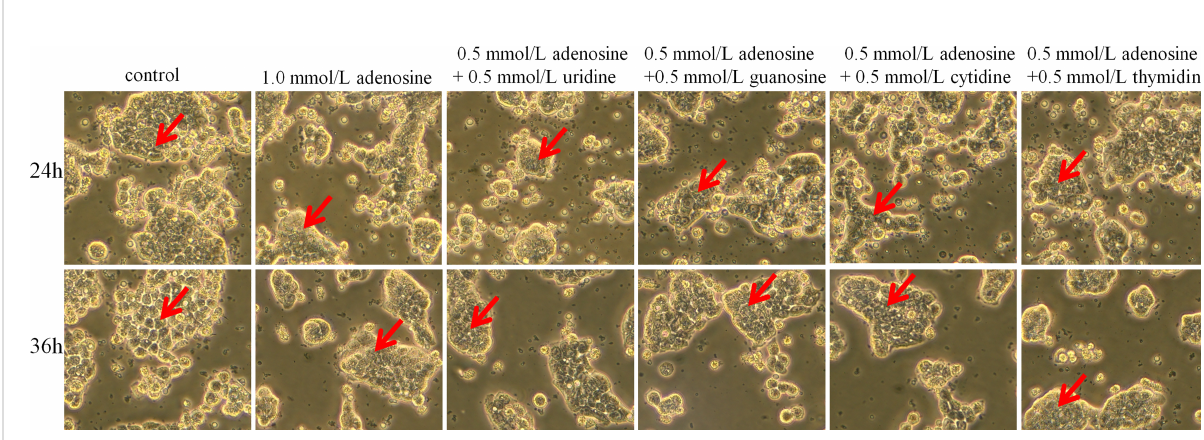
FIGURE 10 Effect ofadenosine and other nucleosides oncell morphology in cocultured HT-29cells + freshly extracted human leucocytes. Cell morphology was obtained by takingbright fi eld images with OLYMPUS inverted microscope (×100). All experiments wererepeated at least three times, and a representative fi gureis displayed. The arrows point toobservation areas